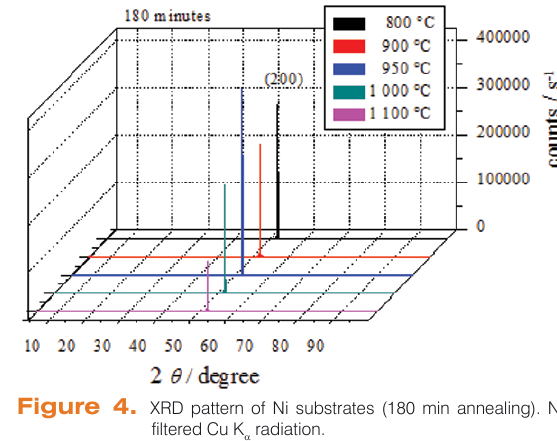
Figure 4. XRD pattern of Ni substrates (180 min annealing). Ni- filtered Cu K a